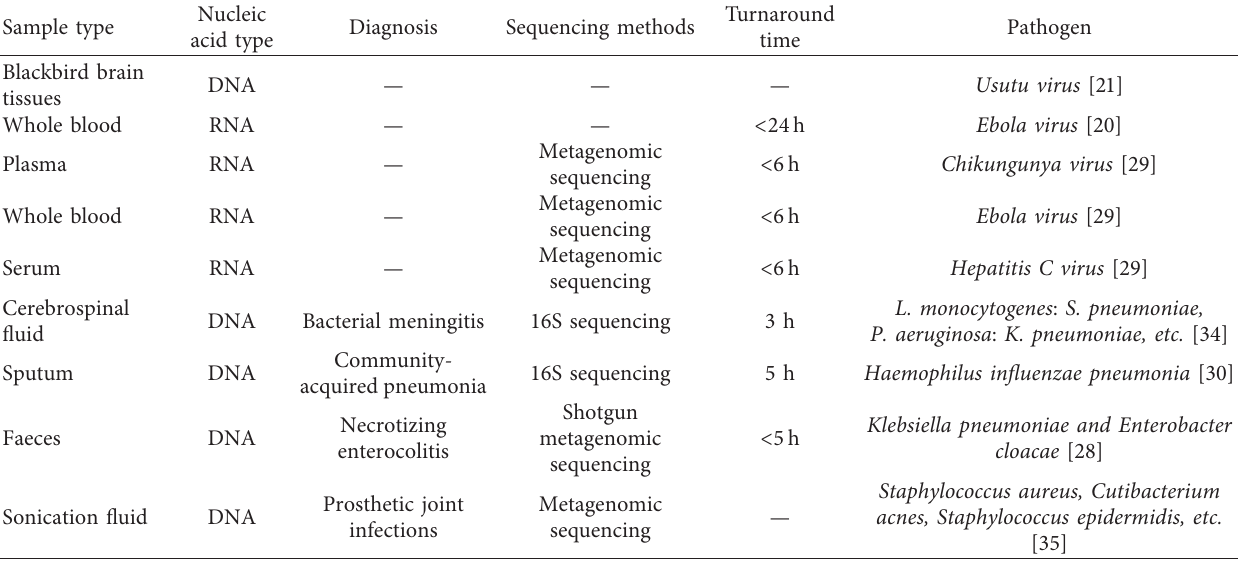
Table 2: Nanopore sequencing can quickly identify pathogens in various clinical samples. Sample